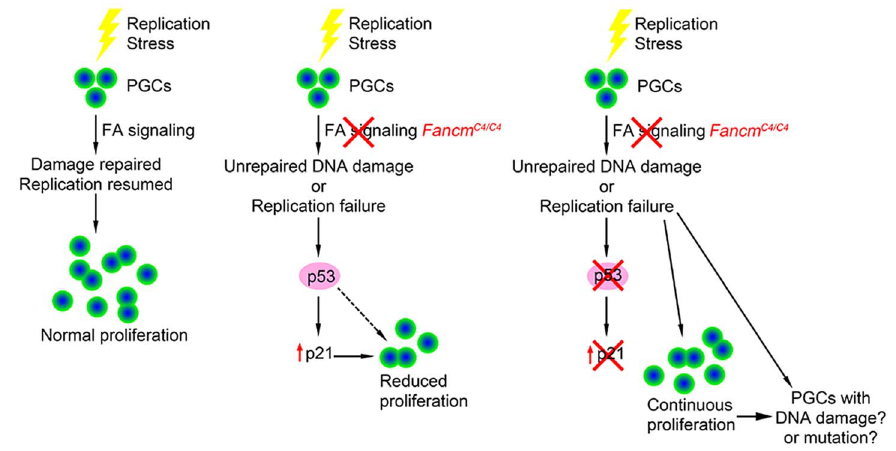
Figure 8. Model of checkpoint responses to replication stress in primordial germ cells.